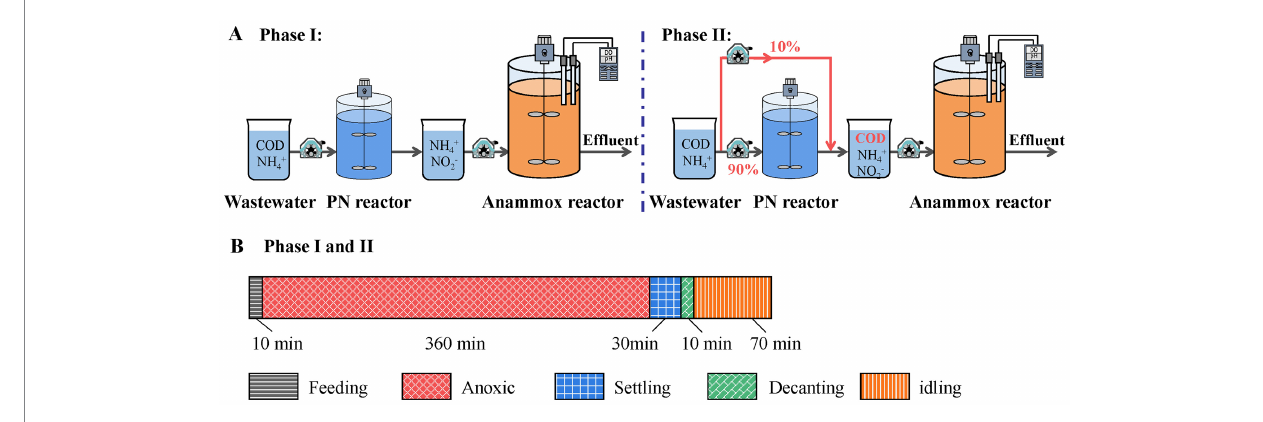
FIGURE 1 The schematic (A) and operational patterns (B) of the mainstream anammox reactor.